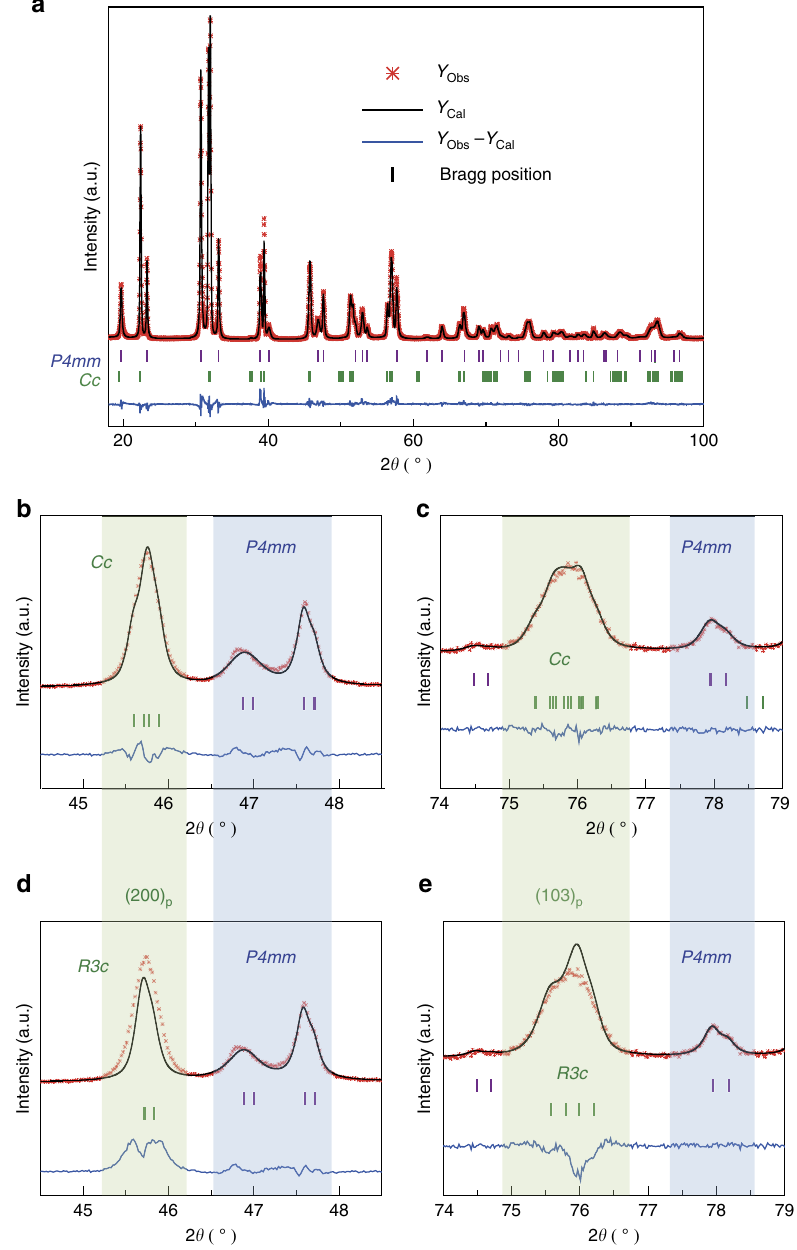
Figure 1 | Crystal structure. ( a ) High-resolution XRD pattern and Rietveld refinement for the Bi 0.68 Pb 0.32 Fe 0.655 Mn 0.025 Ti 0.32 O 3 powder sample, at room temperature, indicating phase coexistence between polymorphs with monoclinic Cc and tetragonal P 4 mm symmetries. Y Obs and Y Cal refer to the measured and calculated intensities, respectively. The refined profiles using the ( b , c ) Cc and ( d , e ) R 3 c symmetries across the (200) p and (103) p reflections (referring to pseudocubic indices) are shown to illustrate the better agreement of the Cc